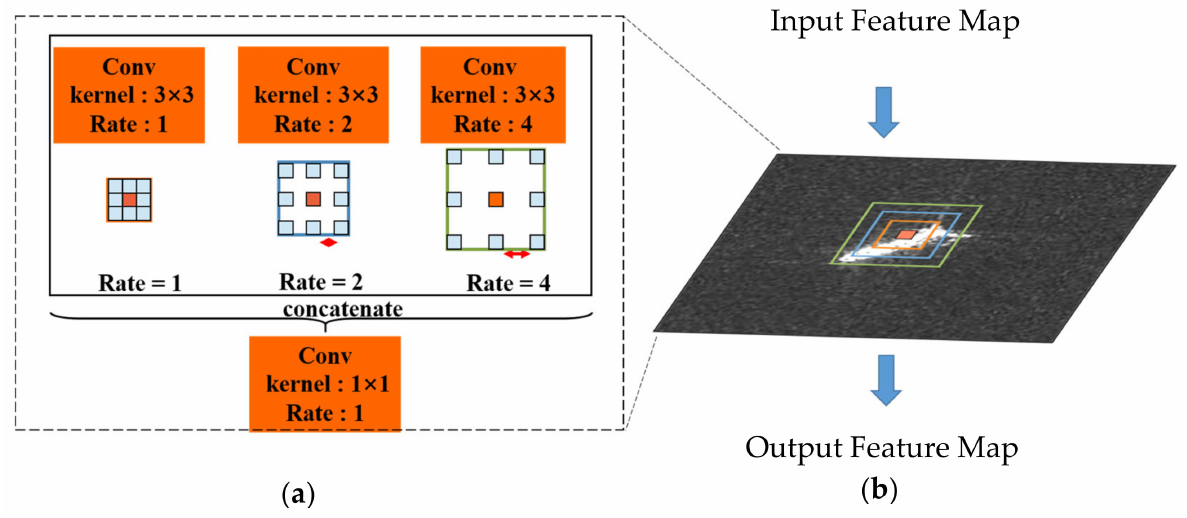
Figure 6. The schematic design of the ACP module. ( a ) The network structure of a specific ACP. ( b ) A schematic diagram representing the process of extracting feature maps at different scales. Different dilation rates mean different receptive